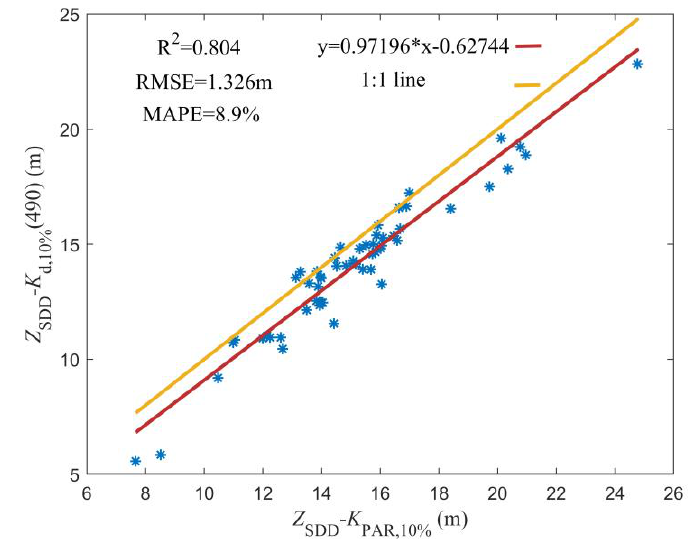
Figure 14. Comparisons of the calculated 𝑍 𝑆𝐷𝐷 values between the two methods.